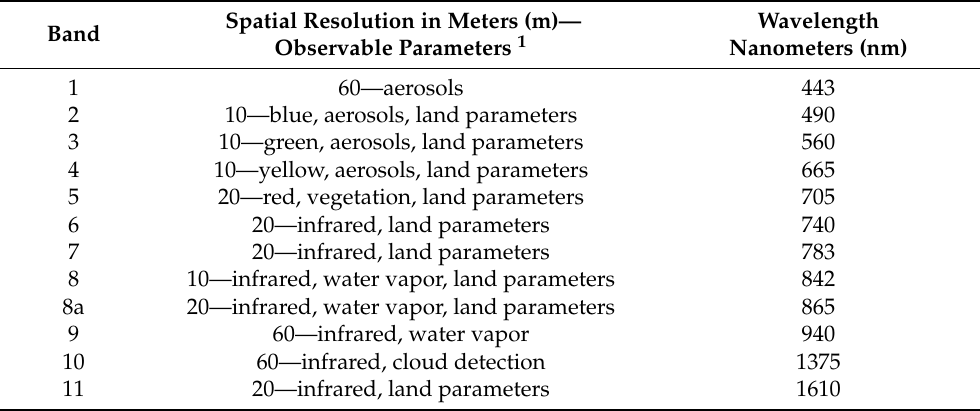
Table 2. Sentinel-2 MSI Electromagnetic Spectrum Bands of Observation.